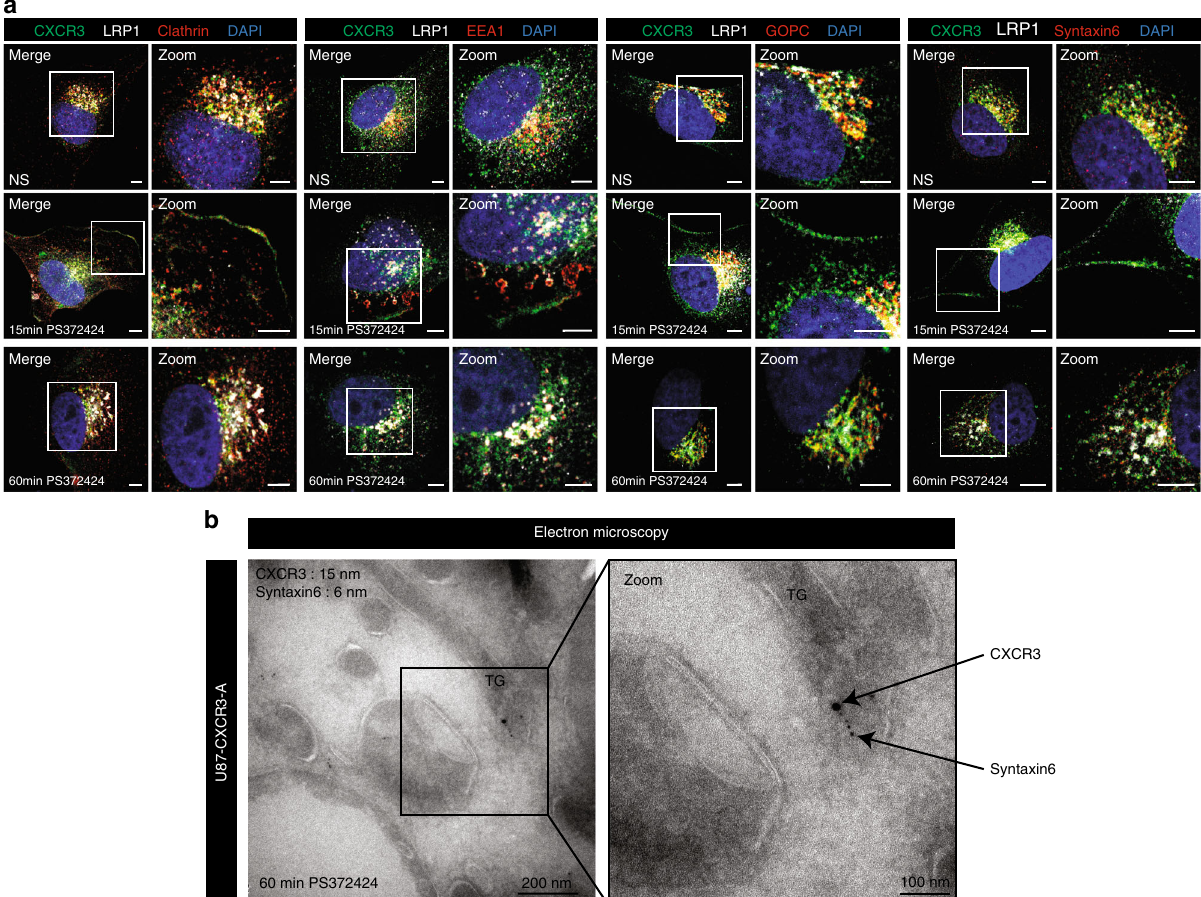
Fig. 5 Internalization, traf fi cking and recycling of CXCR3-A. a Membrane or perinuclear localization of CXCR3 ( λ = 488 nm) and colocalization with LRP1 ( λ = 647nm) in non-stimulated (NS) U87-CXCR3-A cells and upon stimulation with PS372424 at 15 and 60 min. Internalization and recycling of CXCR3 studied by immunostaining for clathrin, EEA1, GOPC, or Syntaxin6 (for each marker λ = 547 nm). Nuclei were stained with DAPI ( λ = 405 nm). Scale: 5 µ m. The experiments have been repeated three times with identical results. b Electron microscopy with immunogold labeling of CXCR3 (15 nm diameter) and Syntaxin6 (6 nm diameter) in ultrathin cryosections of U87-CXCR3-A cells stimulated with PS372424 for 60 min. TG trans-Golgi ( n =